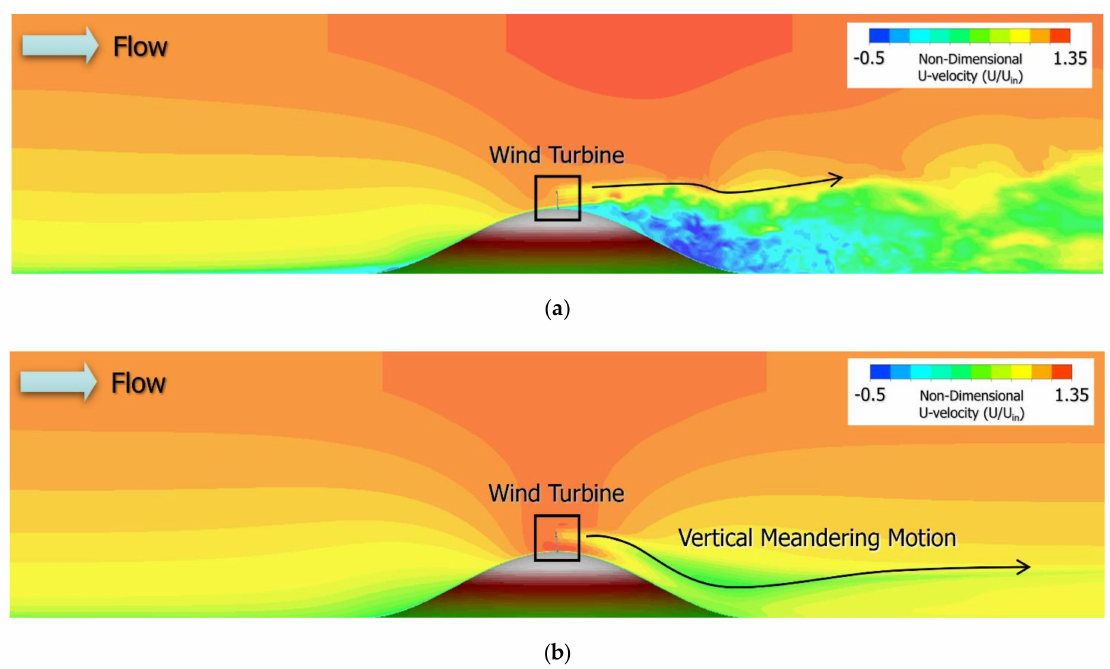
Figure A2. Instantaneous flow patterns of fully developed flow field, including the computational fluid dynamics (CFD) porous disk wake model and the spatial distribution of the corresponding U-velocity. ( a ) Neutrally stratified condition (Ri = 0.0); ( b ) Stable stratified condition (Ri = +